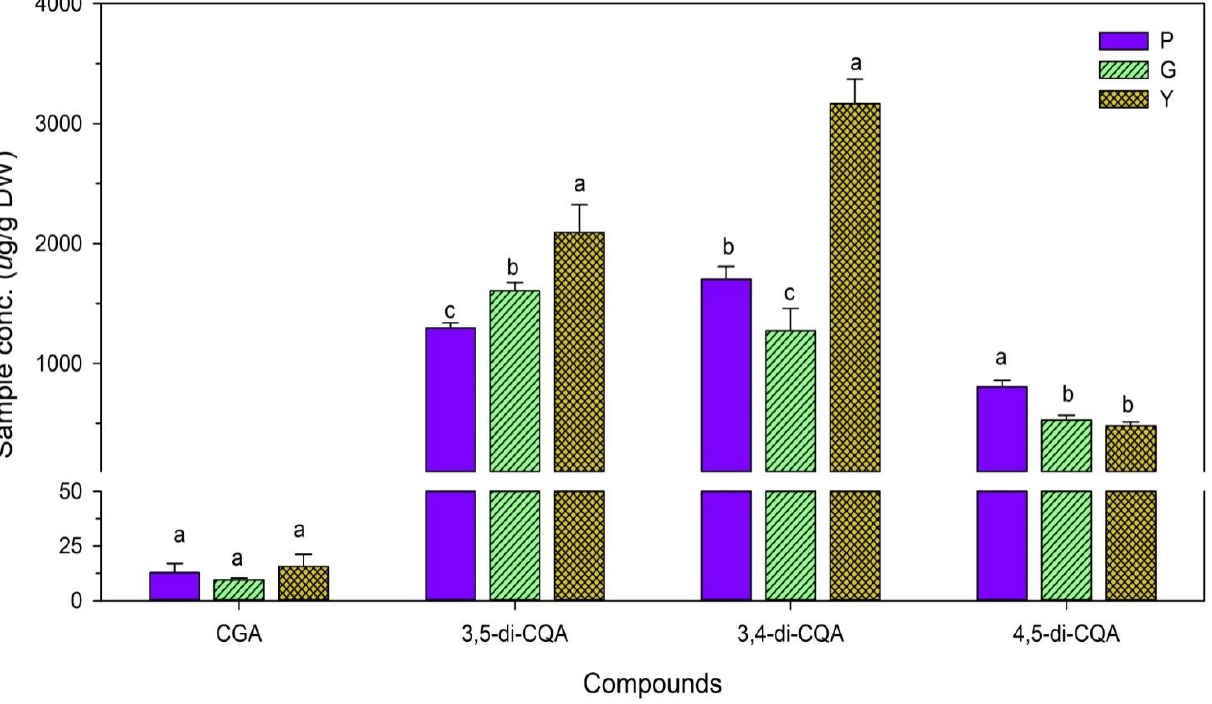
Figure 3. Content ( µ g/g DW) of chlorogenic acid (CGA), 3,5-di-CQA (3,5-dicaffeoylquinic acid), 3,4-di-CQA (3,4-dicaffeoylquinic acid), and 4,5-di-CQA (4,5-dicaffeoylquinic acid) of purple (P, CYY 98-59), green (G, Taoyuan 2), and yellow (Y, CN 1927-16) leaf extracts. All MS/MS data for analytes were collected in the multiple reaction monitoring (MRM) mode, using MassLynx v4.1 software. The concentrations of CGAs were expressed as means ± standard deviations ( n = 3). Means with different letters among the three genotypes of sweet potato leaves indicate statistical significance at p < 0.05.